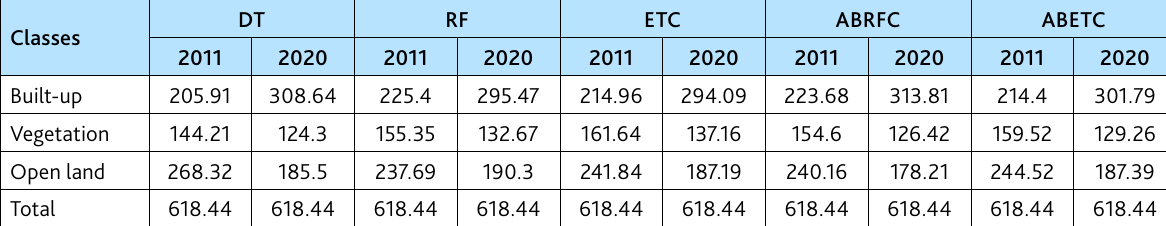
Table 9. Change detection comparison for Ahmedabad data set (Area in sq. km.)